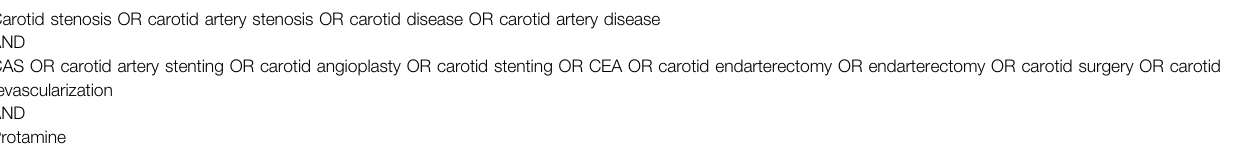
TABLE 1 | The speci fi c search strategy.